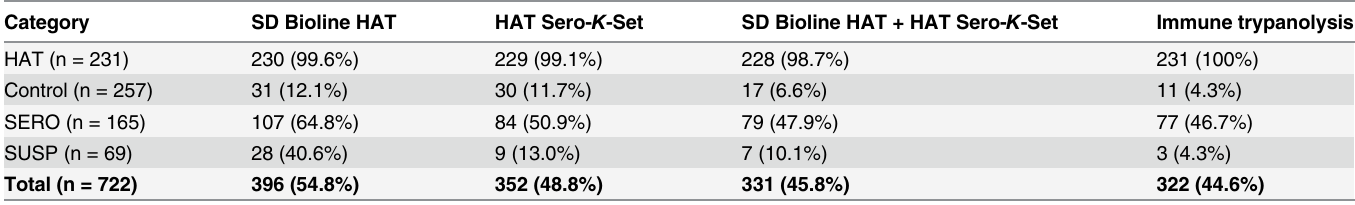
Table 2. Number of positive test results by type of study